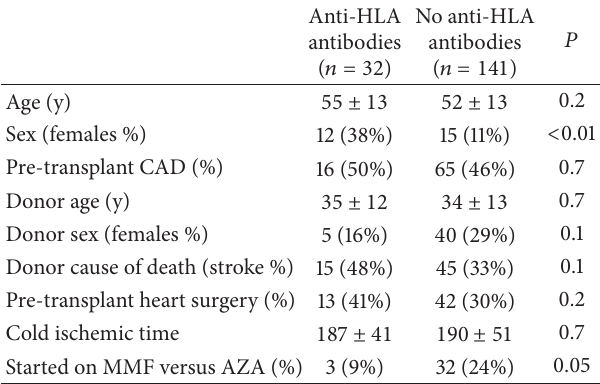
Table 1: Baseline characteristics according with HLA